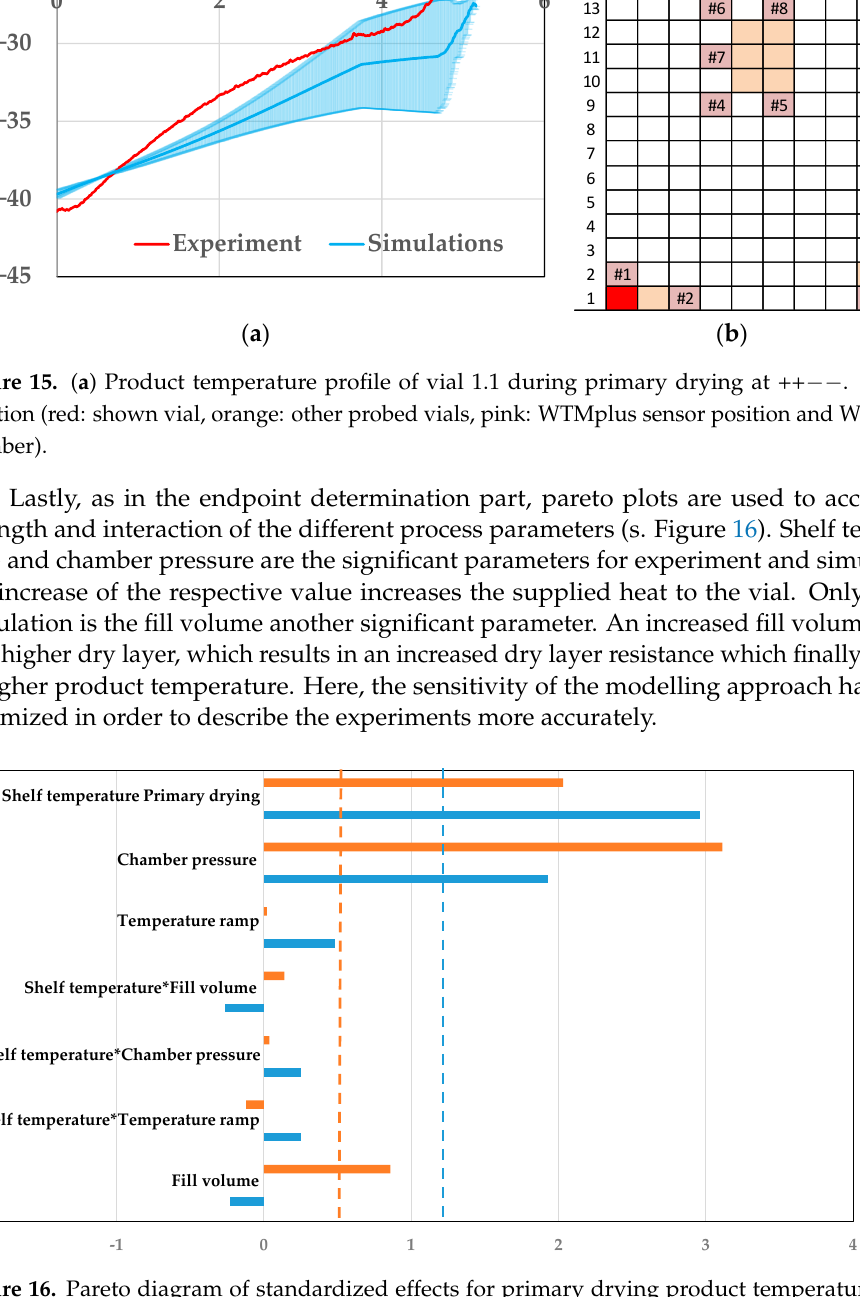
( b ) Figure 14. ( a ) Product temperature profile of vial 12.6 during primary drying at the CP. ( b ) Vial position (red: shown vial, orange: other probed vials, pink: WTMplus sensor position and WTMplus number). The accuracy for the prediction of the edge vial is lacking since the experimental point